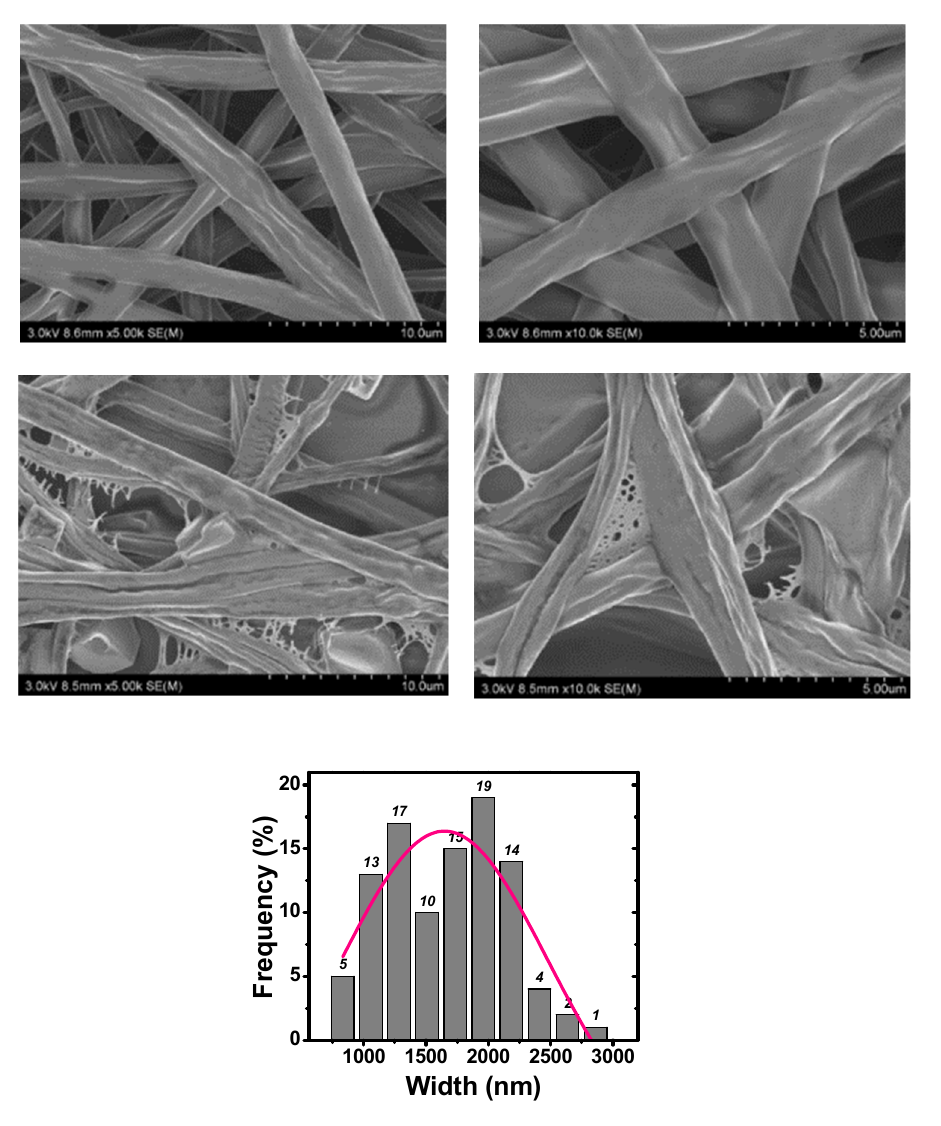
Figure 3. SEM illustration for Sample 4.